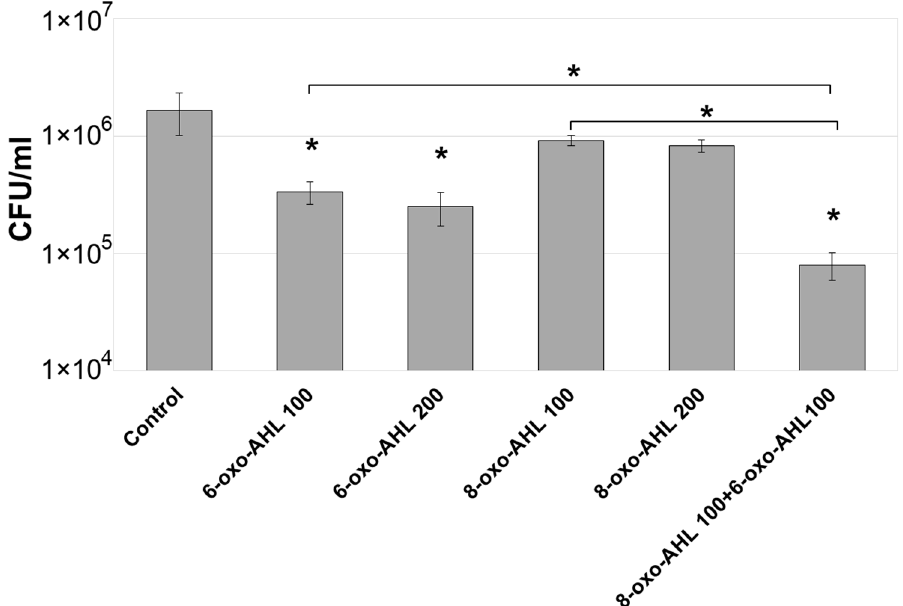
Figure 1. The colony forming unit (CFU) titer at which adaptive proliferation was terminated in Pectobacterium atrosepticum starving cultures with a low initial population density (10 3 CFU/mL). Starving cultures were incubated in the absence of exogenous acyl homoserine lactones (AHL) (Control), or in the presence of either 100 or 200 µ M of either 6-oxo-AHL or 8-oxo-AHL, or in the presence of both 6-oxo-AHL and 8-oxo-AHL each at 100 µ M concentration. The presented values are the means ± SD of three biological replicates. Asterisks (*) show a significant difference (Mann–Whitney two-sided test, p < 0.05) from the control or between the variants designated by brackets.